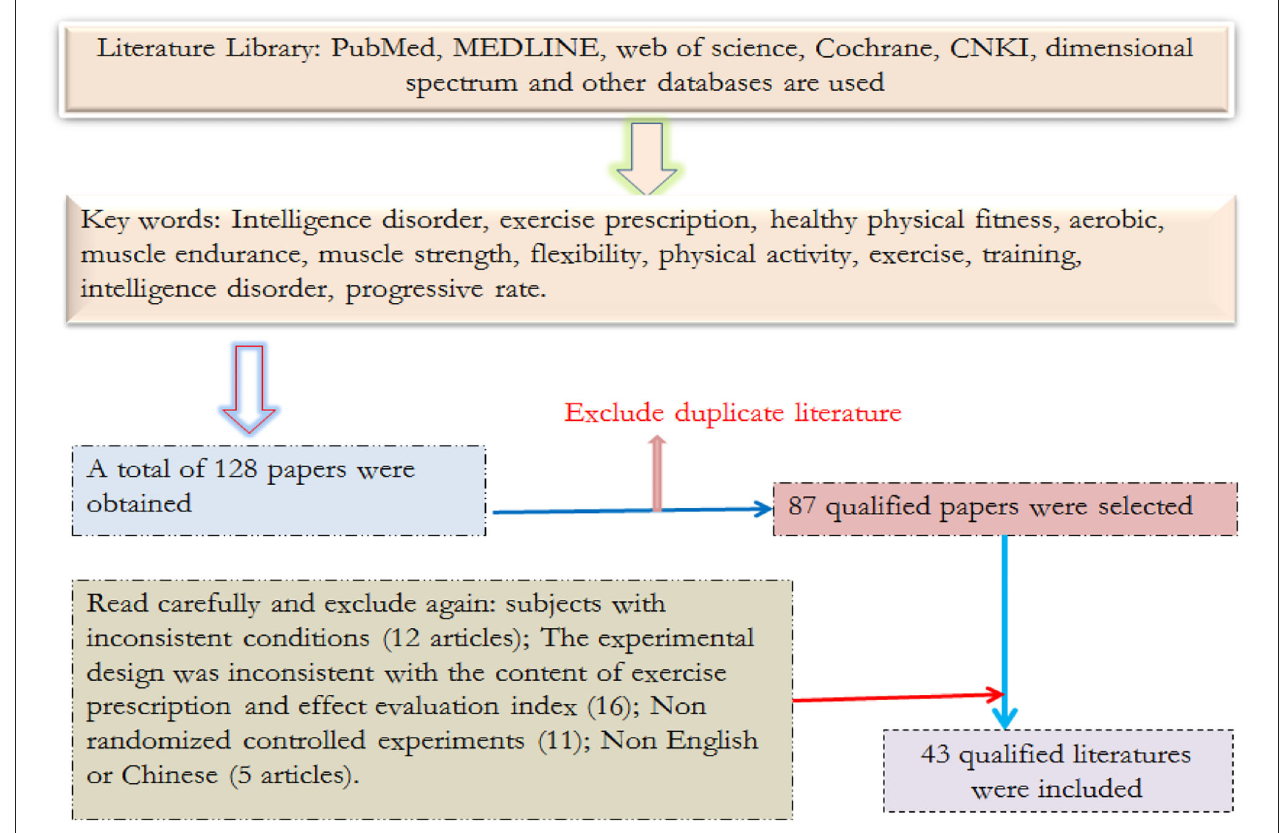
FIGURE 1 | Schematic diagram of literature